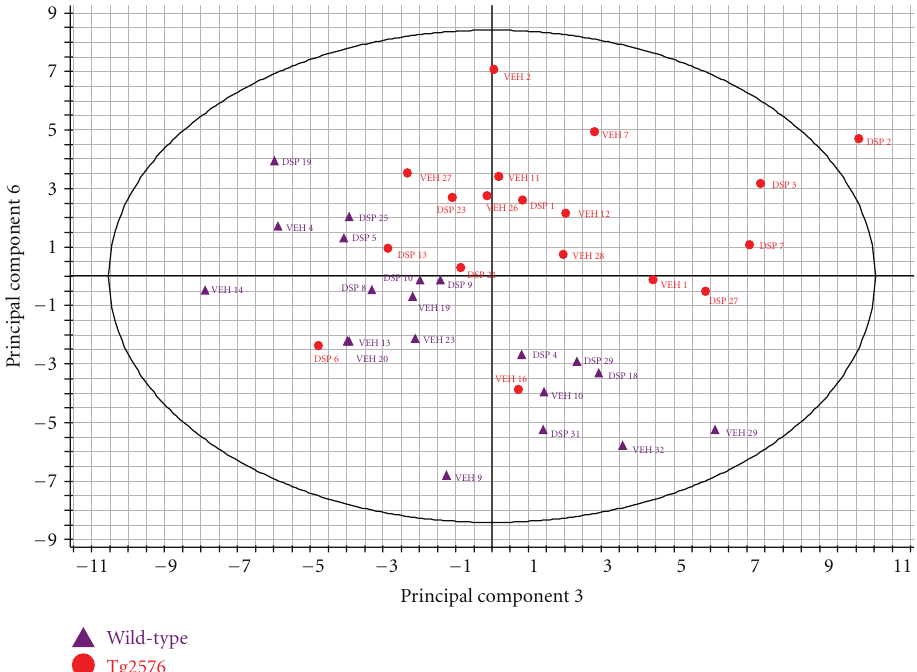
Figure 2: Principal components analysis. From an autofit model that yielded 7 principal components, a combination of PC3 and PC6 gives a separation of the wild type and transgenic samples of brain metabolites. This figure shows the scores plot, derived by principal components analysis, as a combination of Principal Component (PC) 3 on the x -axis and PC 6 on the y -axis. Each transgenic animal is represented by a red circle, each wild type by a purple triangle. Each point is labeled either with VEH for vehicle treatment or DSP for drug treatment followed by the number assigned to an individual mouse after assignment to a treatment group, but before any experimental procedure. The clustering observed in this plot indicates separation of the wild-type and transgenic samples based on the global profile of all of the brain metabolites detected in our